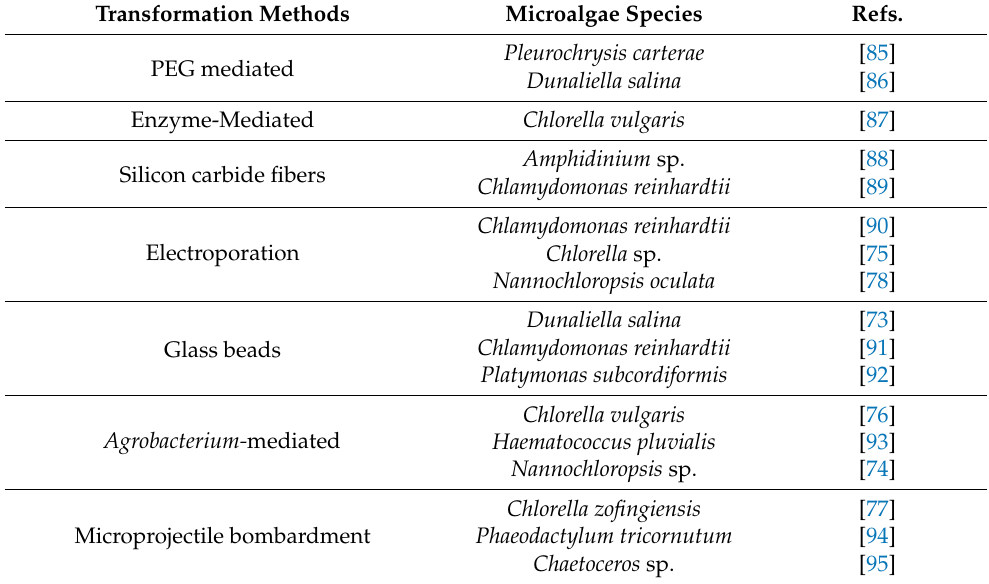
Table 1. Transformations of some microalgae